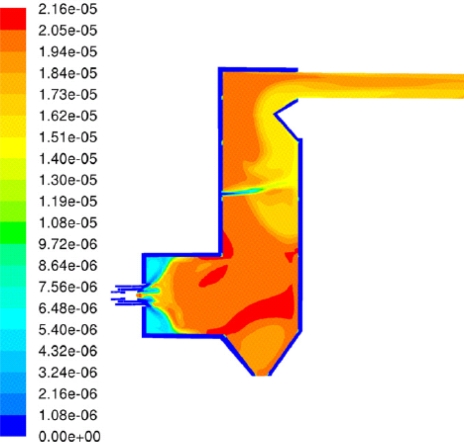
Predicted contours of potassium concentration (mol/mol) [39].